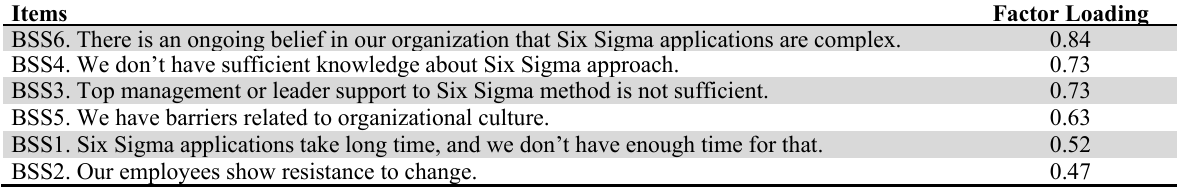
Exploratory Factor Analysis of Barriers of Six